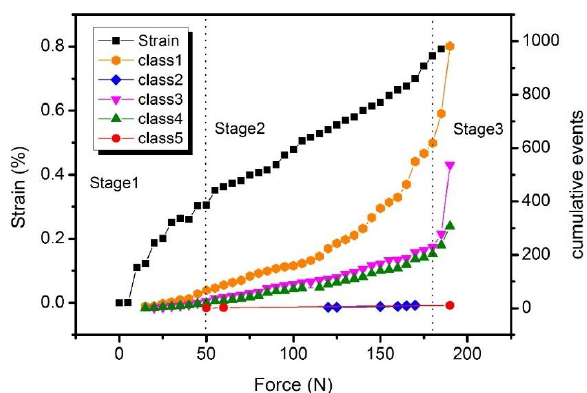
Figure 25: SEM micrographs of the failed C/SiC mini-composites